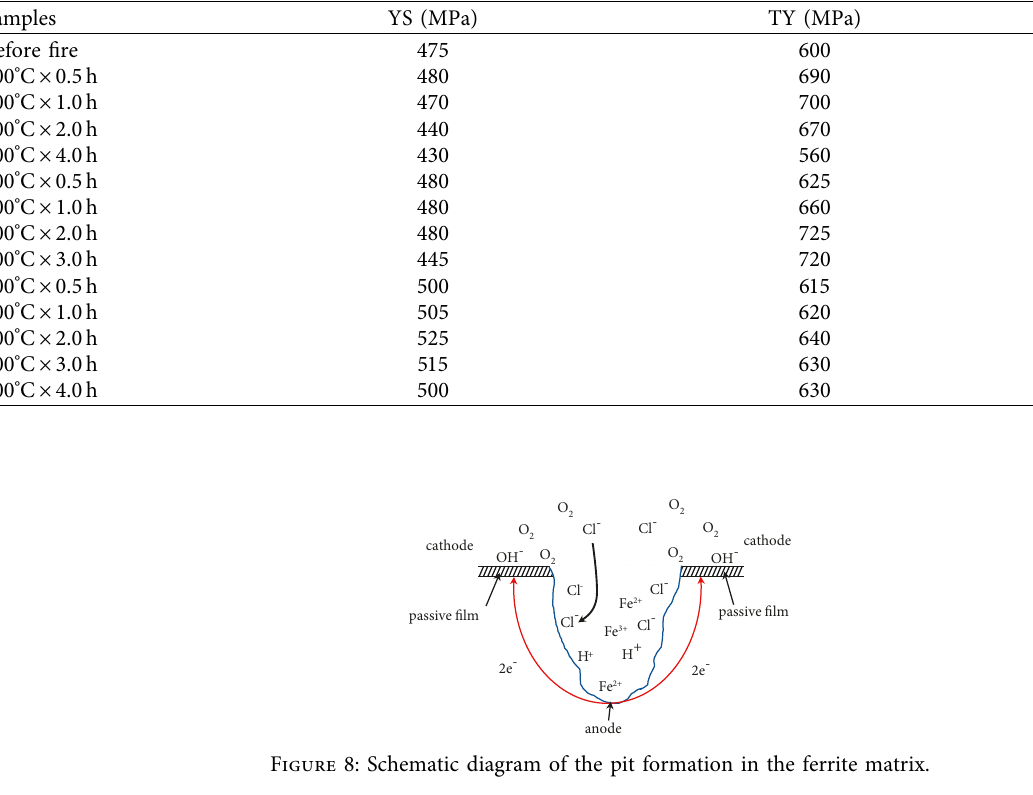
Table 2: The postfire mechanical properties of the SFSS.